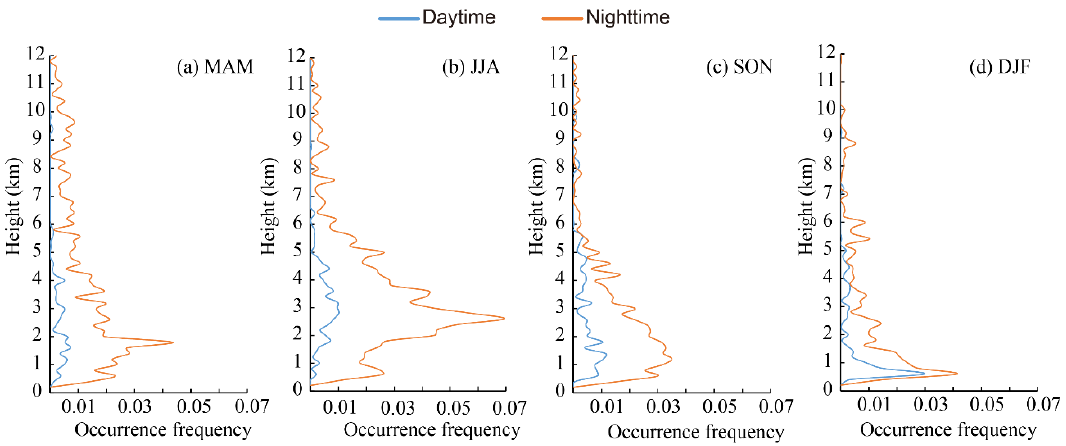
Figure 6. Vertical distribution of occurrence frequencies of polluted dust layer in the daytime and nighttime in the Aral Sea region from CALIPSO observations for four seasons.